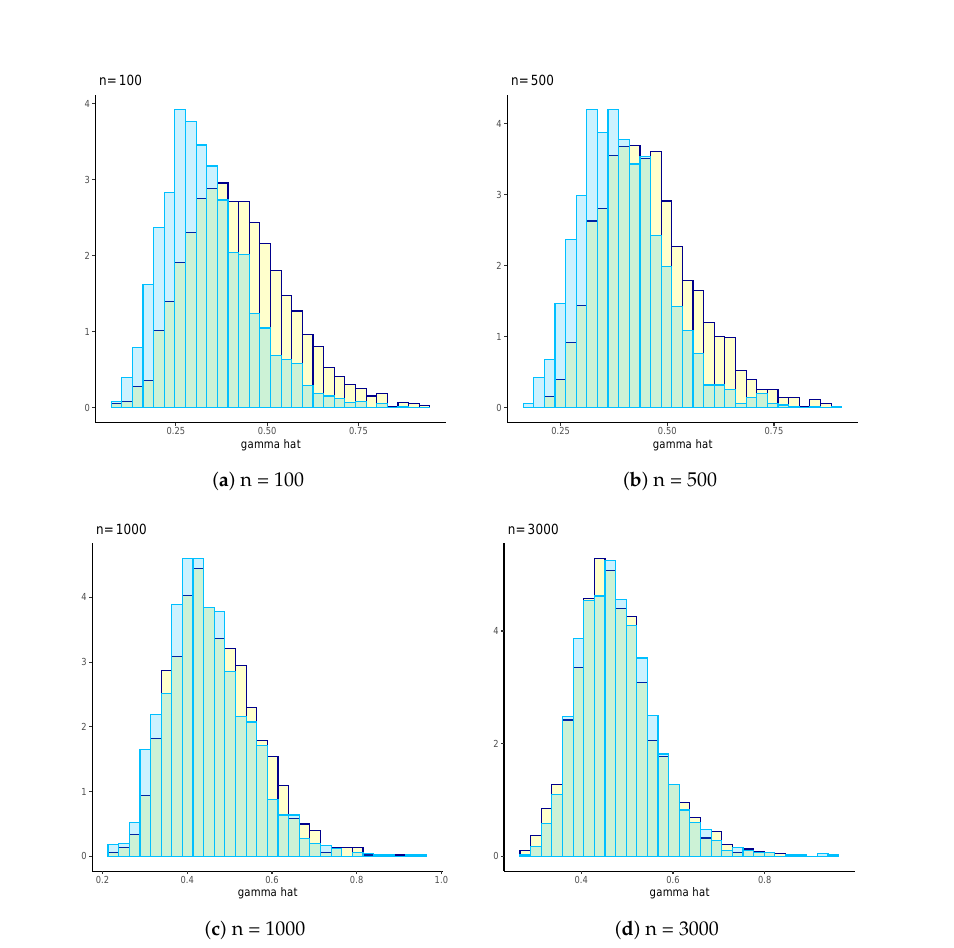
Figure 2. Histograms of the empirical distribution of ˆ γ k for selected sample sizes; k = n 0.5 ; data samples are generated from a Fréchet(2) distribution. Yellow: values obtained by Montecarlo simulations (2000 iterations); blue: values obtained by Algorithm 1 (2000 iterations). The value of γ used has been selected randomly from a pool of estimated